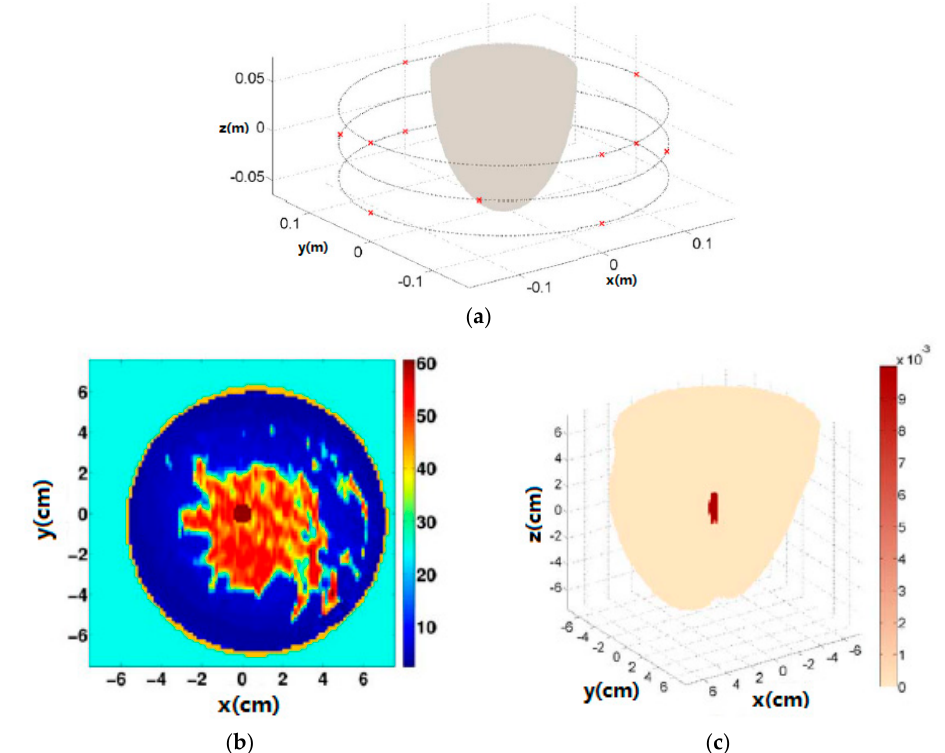
Figure 2. ( a ) CS-based MWT configuration; ( b ) MRI-based breast phantom; ( c ) 3D reconstructed breast image.